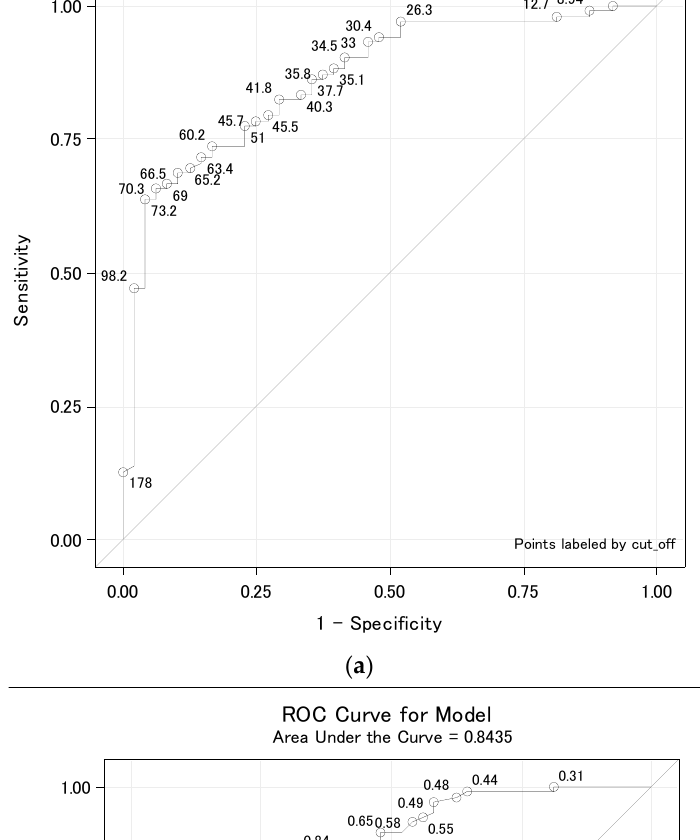
ROC Curve for Model Area Under the Curve = 0.8435